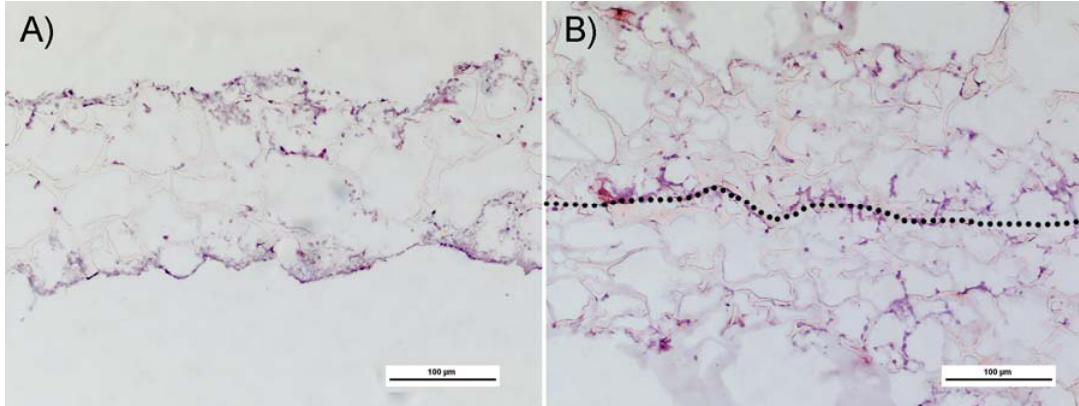
Figure 6. Photomicrographs of H&E stained CUPE 1.2 cross-sections after 2 weeks of cell culture. (A) Single scaffold sheet. (B) 2 scaffold sheets were shown to have bonded together using 3T3 fibroblasts (scale bar = 100 μ